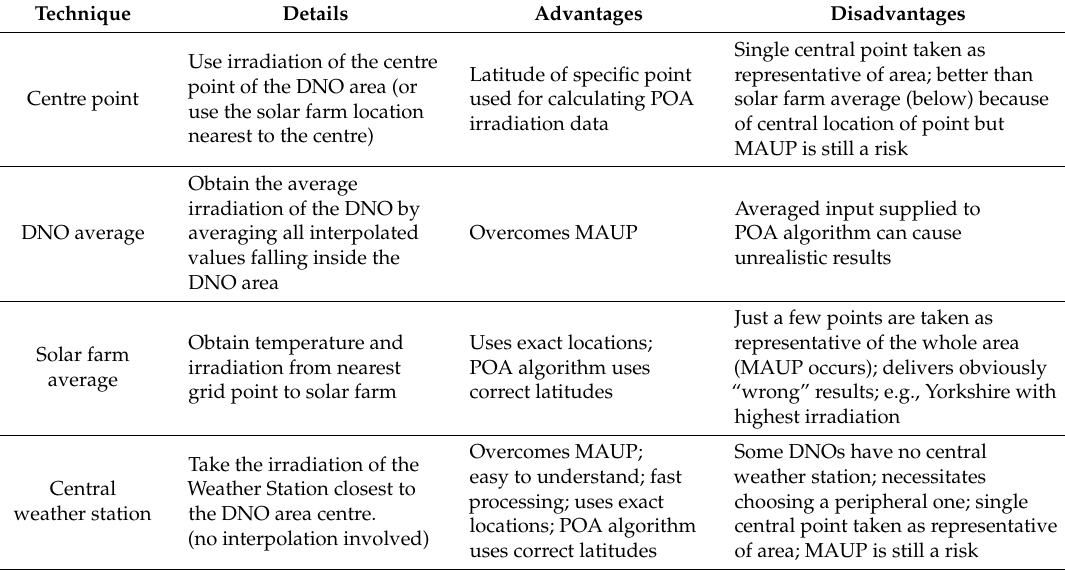
Table 1. Alternative solutions to the Modifiable Area Unit problem (MAUP) for solar farms aggregated by distribution network operator (DNO)